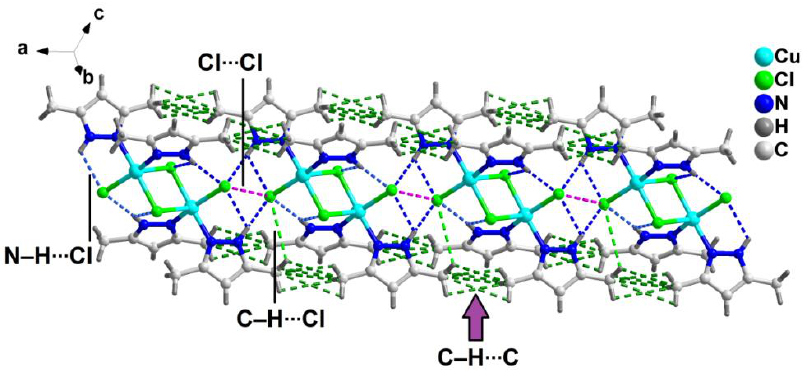
Figure 4. The 1D supramolecular chain of compound 2 assisted via the N–H ··· Cl, C–H ··· Cl hydrogen- Figure 4. The1D supramolecular chain of compound 2 assisted via the N‒H···Cl, C‒H···Cl hydrogen- bonding and the non-covalent C–H ··· C and unconventional Cl ··· Cl interactions. bonding and the non-covalent C‒H···C and unconventional Cl···Cl interactions.